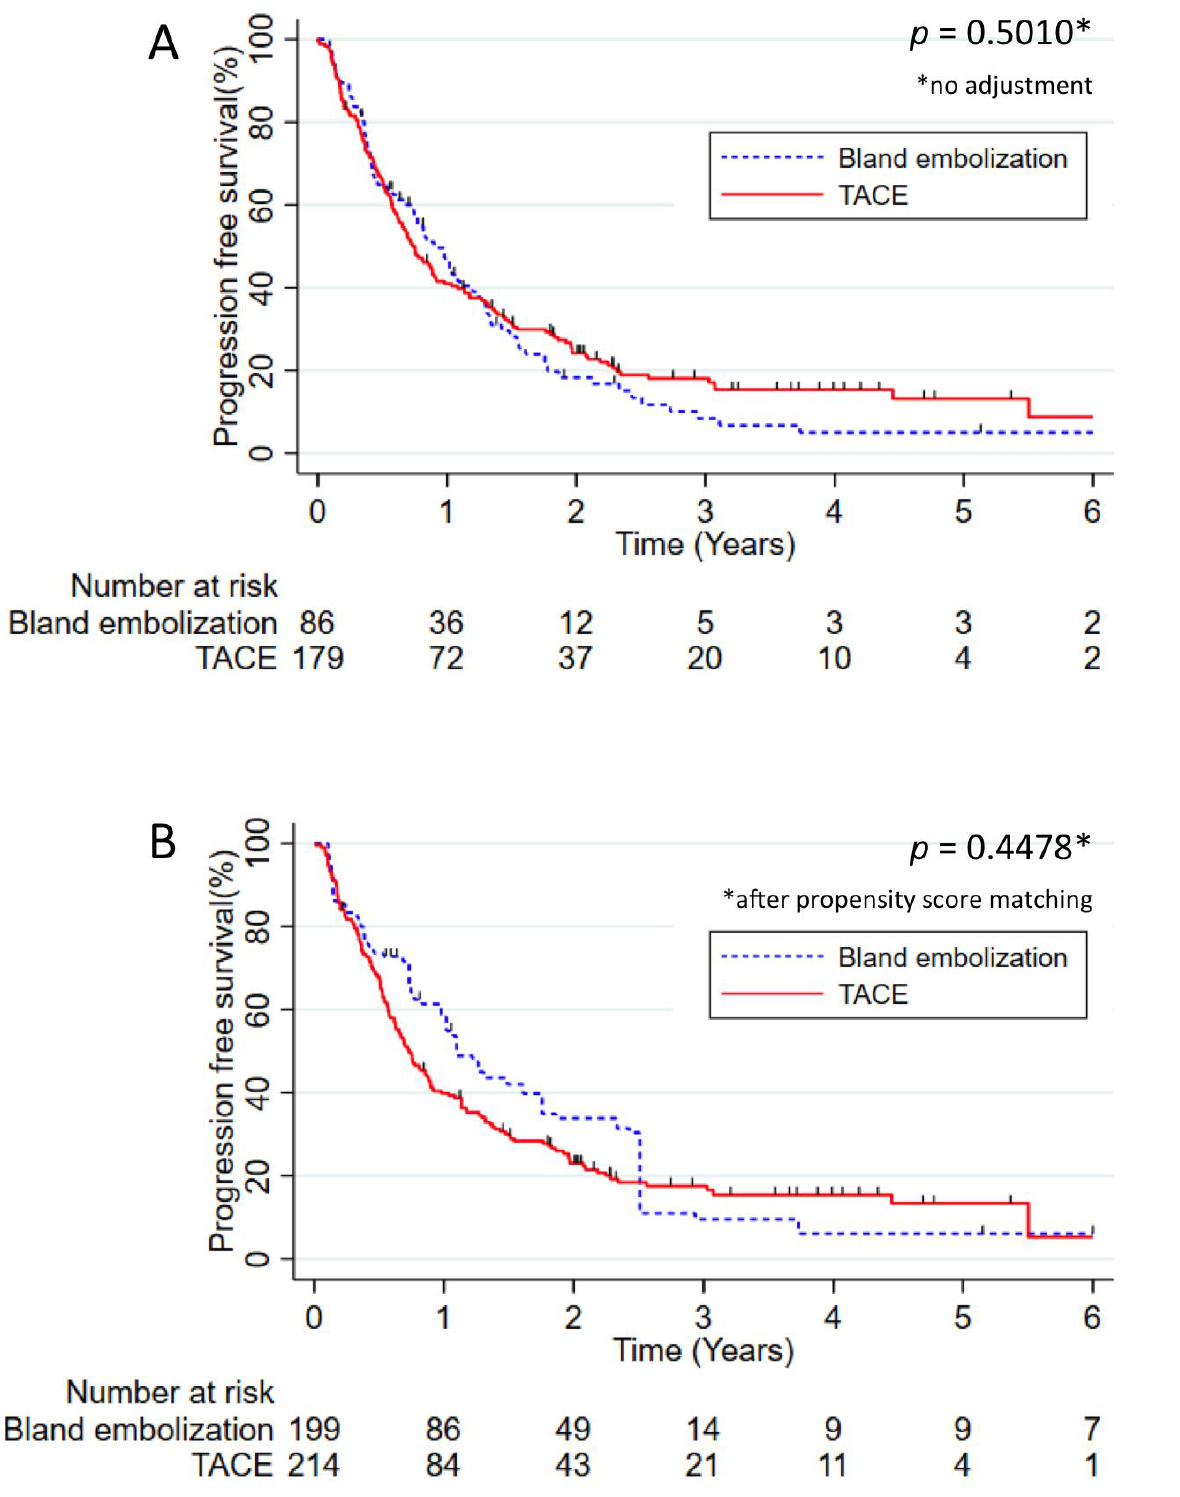
Figure 2. Progression-free survival in patients treated by TACE versus patients treated by TAE. ( A ) Progression-free survival without adjustment and ( B ) progression-free survival adjusted using the propensity score. The results were analyzed using the Kaplan–Meier method and compared using the log rank test. Numbers at risk were reported under the x -axis.